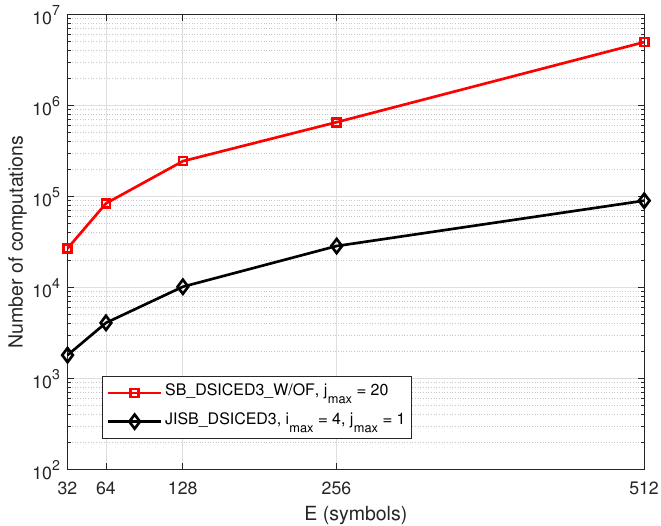
Figure 13. Number of computations versus E ; R = 1/2, β E = 4, p B / σ 2 w = 10 dB, p SI / σ 2 w = 30